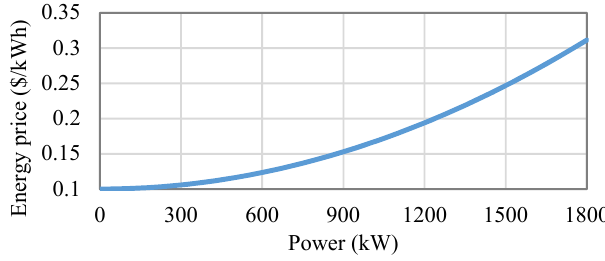
Figure 4. Energy unit price versus purchased power.